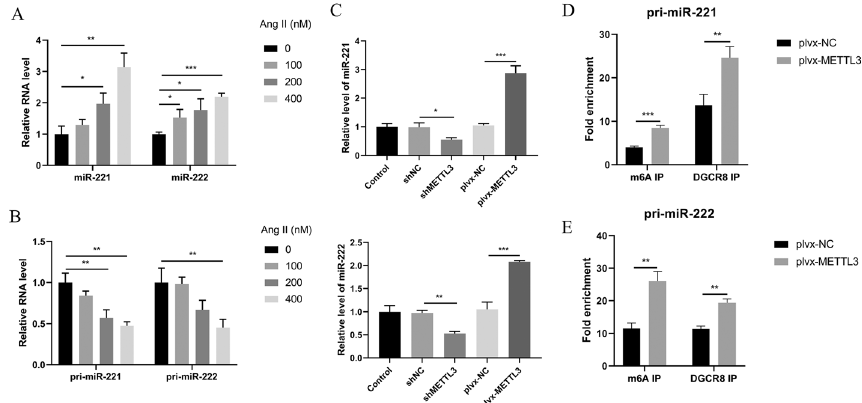
Fig. 3 Maturation of miR-221/222 was promoted by METTL3 in an m6A-dependent manner. A qRT-PCR detected the expression of miR-221 and miR-222 in Ang-II-induced NRCMs. n 3. B qRT-PCR detected the = expression of pri-miR-221 and pri-miR-222 in Ang-II-induced NRCMs. n 3. C METTL3 was overexpressed = and inhibited respectively after transfecting plvx-METTL3 or shMETTL3 into NRCMs. qRT-PCR detected the expression of miR-221 and miR-222. n 3. D Detection of pri-miR-221 binding to DGCR8 or m6A modification = by immunoprecipitation experiments in control and METTL3 overexpression NRCMs. n 3. E Detection of = pri-miR-222 binding to DGCR8 or m6A modification by immunoprecipitation experiments in control and METTL3 overexpression NRCMs. n 3. * P < 0.05, ** P < 0.01, *** P < =